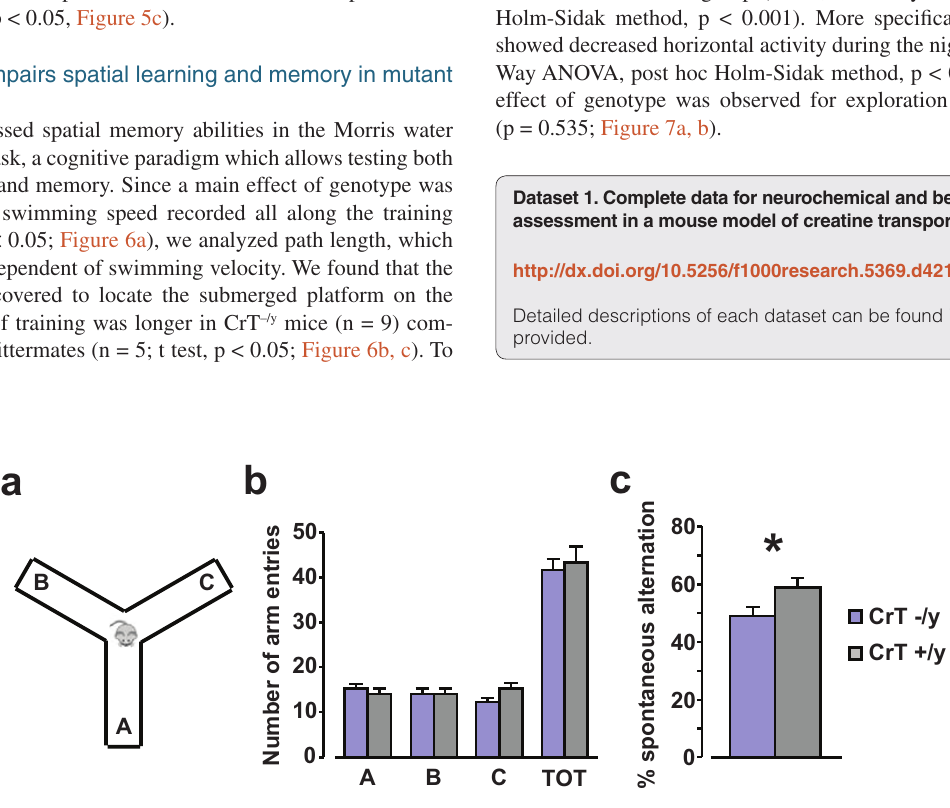
Figure 5. Impairment of Y-maze spontaneous alternation rate in CrT –/y mice. ( a ) Schematic diagram of the Y maze apparatus. ( b ) Histograms depict the mean number of entries in the single arms of the maze (A, B, C) and the total number of arm entries for the different experimental groups: animals of both groups equally explored all the three arms of the maze and general exploratory behavior of CrT –/y animals (n = 9; A: 15.22 ± 1.12, B: 14.22 ± 1.08, C: 12.22 ± 1.05, TOT: 41.67 ± 2.41) was totally comparable to that exhibited by WT littermates (n = 9; A: 14.00 ± 1.26, B: 14.11 ± 1.29, C: 15.22 ± 1.27, TOT: 43.33 ± 3.58; Two-Way ANOVA, post hoc Holm-Sidak method, p = 0.640, p = 0.966, p = 0.252, p = 0.523 respectively). ( c ) Alternation rate in the Y maze was significantly lower in CrT –/y mice (49.24 ±